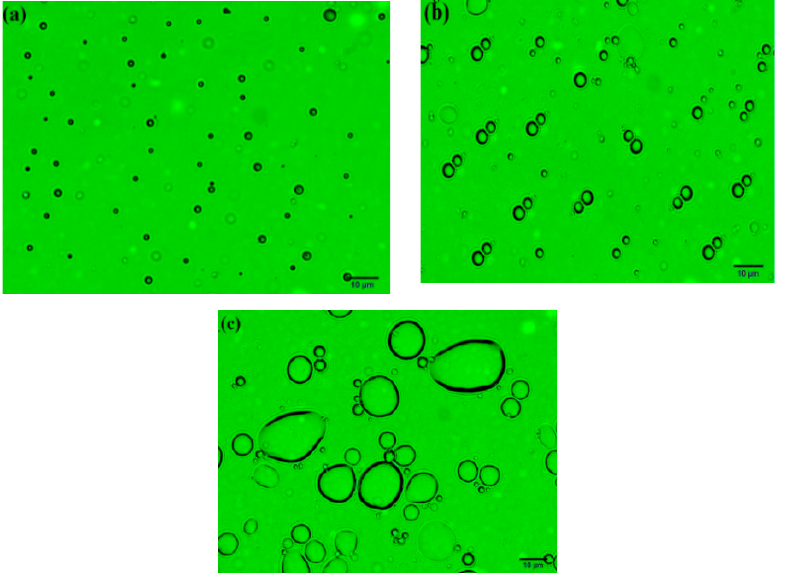
Figure 5. Optical microscopic images of W/O emulsion (volumetric ratio 90:10) ( a ) blank sample after a couple of weeks (at 60 °C), ( b ) after 1 h in the presence of 500 ppm of ATEI-IL, and ( c ) after 2 h in the presence of 500 ppm of ATEI-IL.